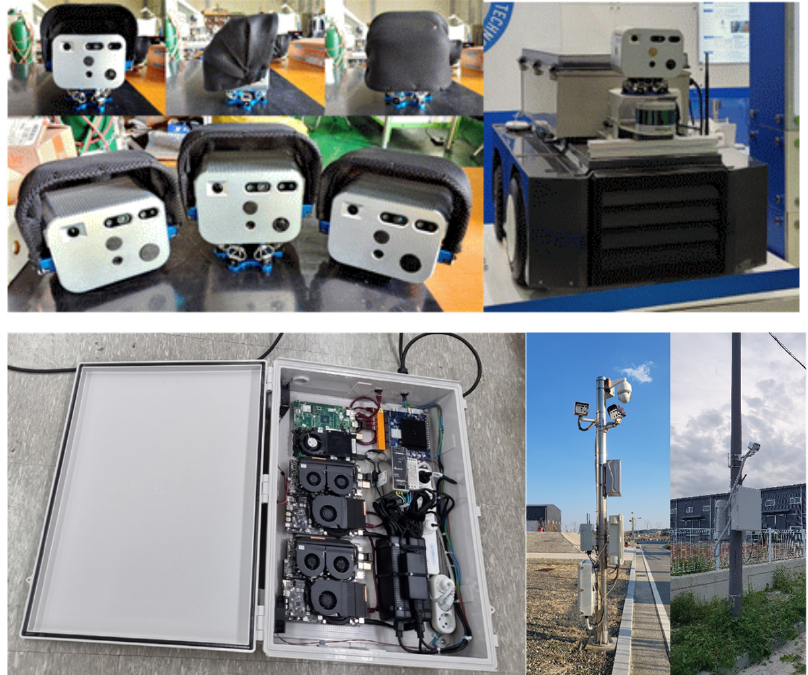
Figure 17. Multi-modal sensor module mounting: ( top ) multi-modal sensor module and mounted on mobile agents; ( bottom ) computing system and fixed agents with multi-modal sensor module.